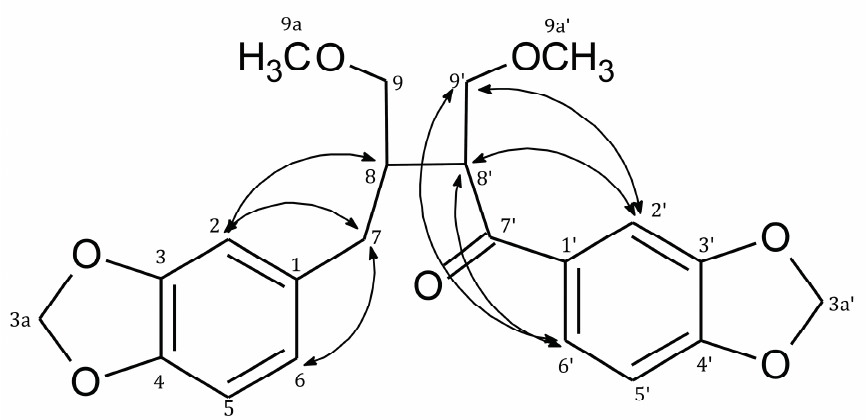
Figure 2. Selected ROESY correlations of 1